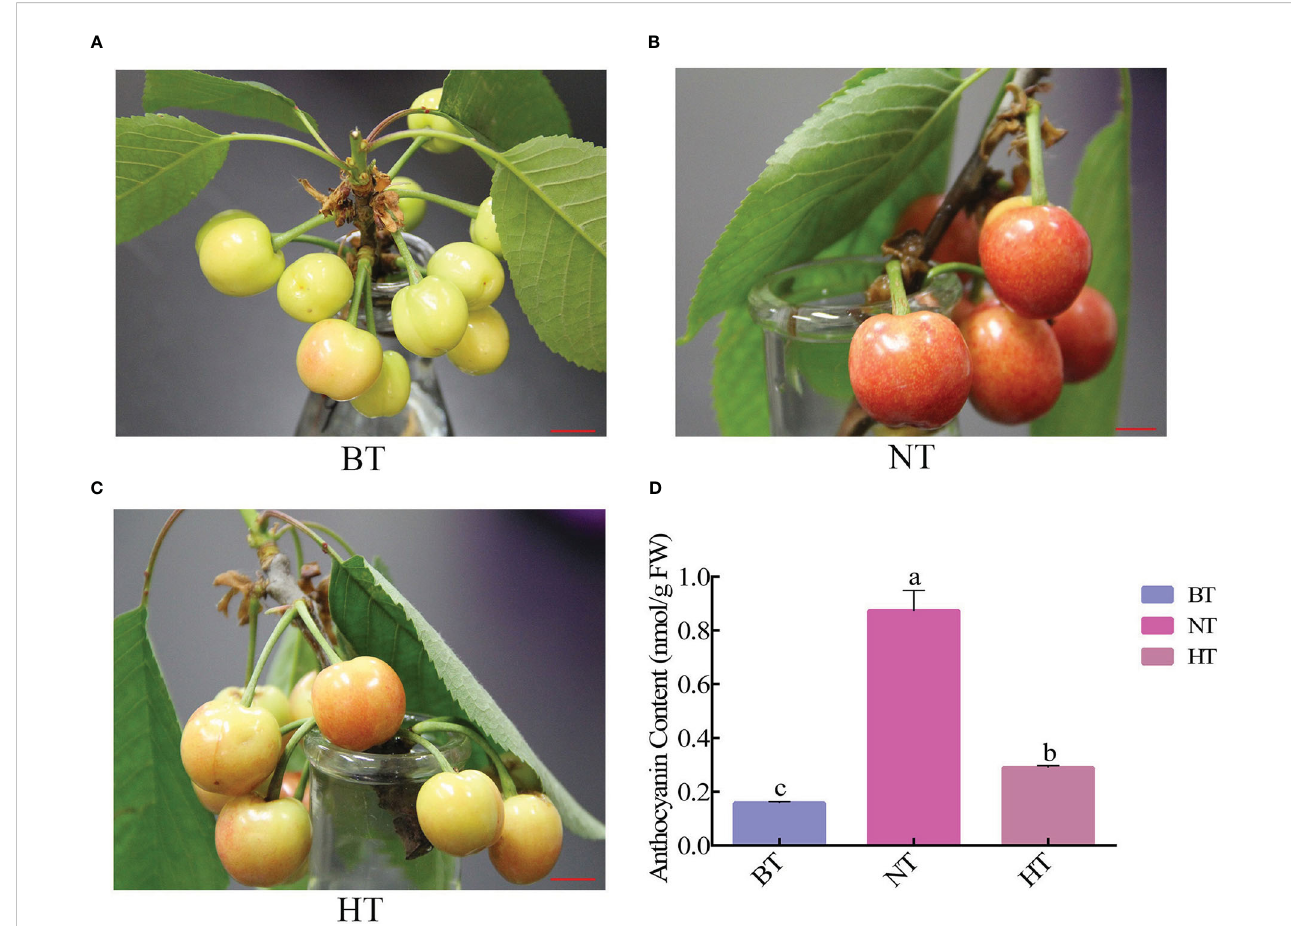
FIGURE 1 High temperature represses anthocyanin accumulation in sweet cherry peel. (A) Phenotype of sweet cherry before treatment (BT). (B) Phenotype of sweet cherry treated at normal temperature [NT, 14°C (night)/24°C (day)]. (C) Phenotype of sweet cherry treated with high temperature [HT, 24°C (night)/ 34°C (day)]. (D) The anthocyanin content in different temperature treatment groups. The different letters indicate signi fi cant differences among different treatments according to Duncan ’ s test (p <